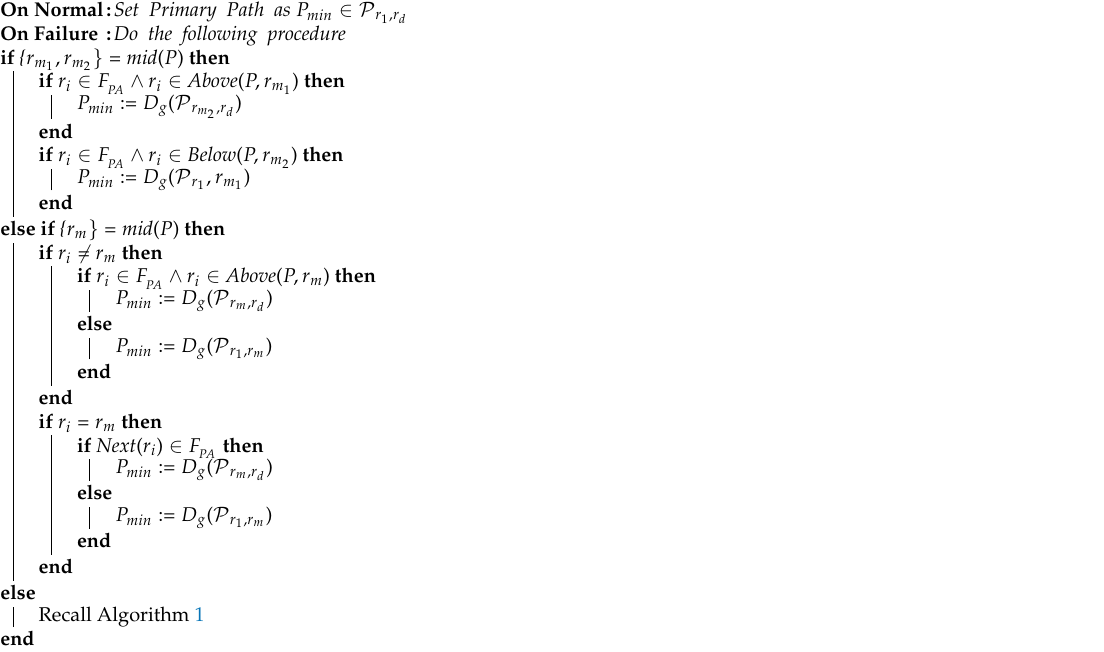
Algorithm 3 Find the Shortest Path with Dijkstra’s from End-to-Mid in a Graph G